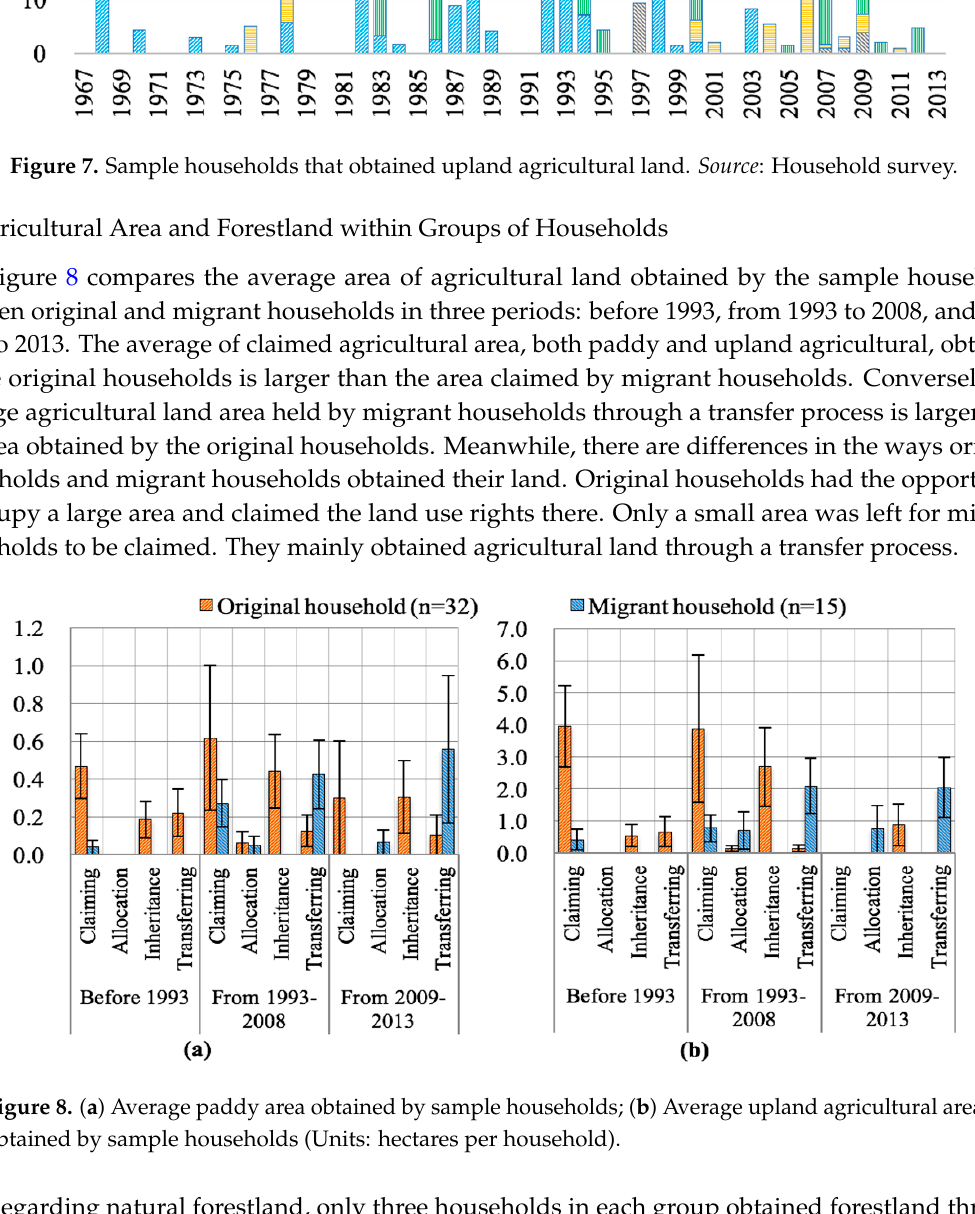
Figure 7. Sample households that obtained upland agricultural land. Source : Household survey.